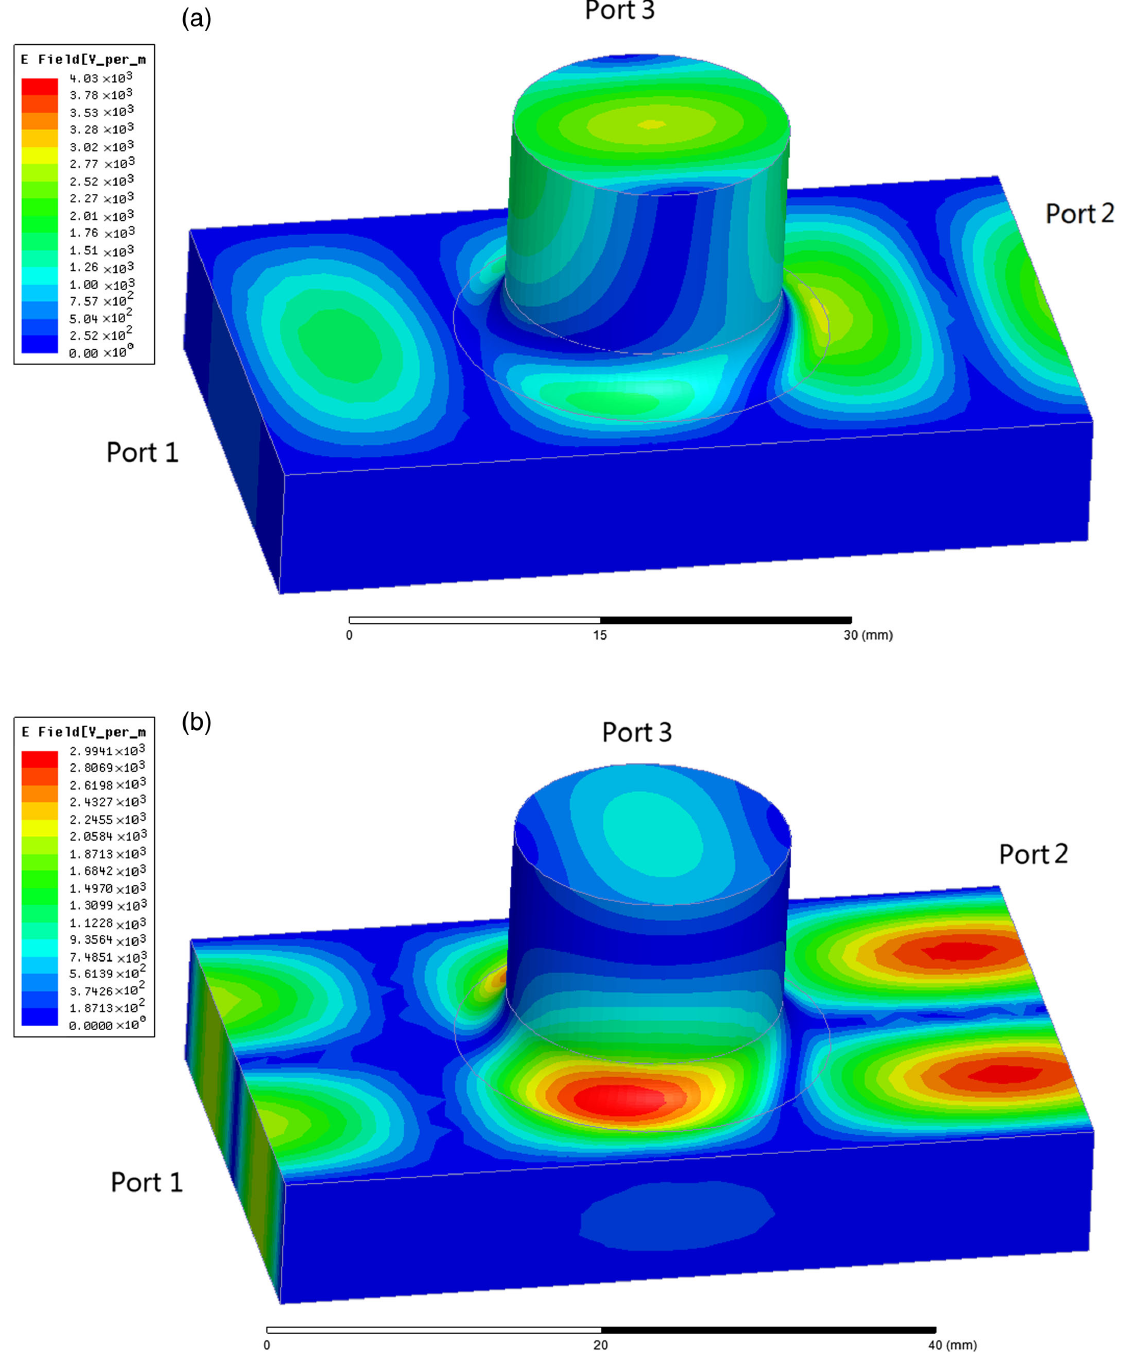
FIG. 5. A snapshot of E field patterns on the mode converter. Port 1 and port 2 are T overmoded rectangular waveguides, and port3 is the circular waveguide. A. The input power on port1 is 1 W in TE10 modes. B. the input power on port1 is 1 W in TE20